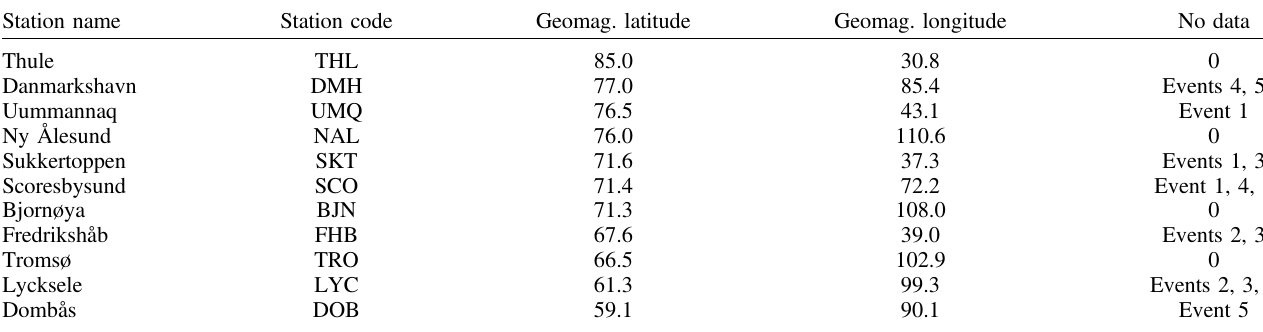
Table 2. The locations of the geomagnetic observatories used in the study.